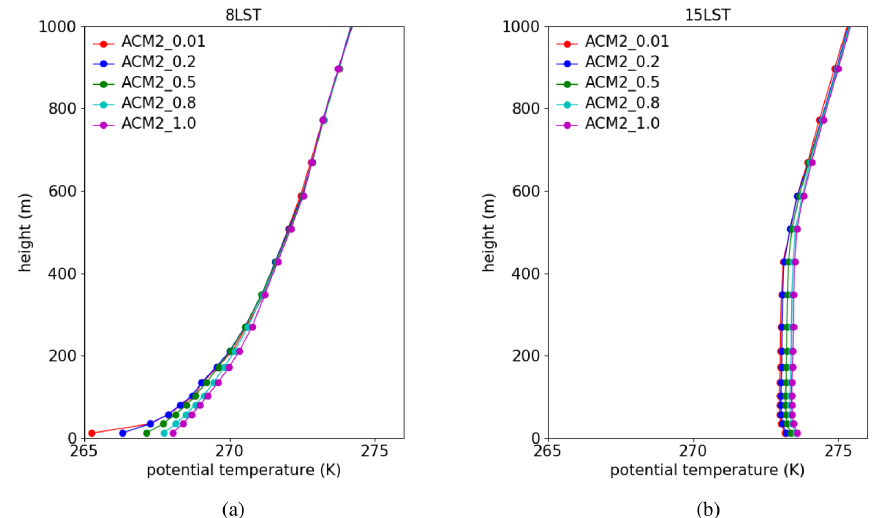
Figure 4. The vertical profiles of the potential temperature predicted by the ACM2 scheme with different K z min values at (a) 08:00LST and (b) 15:00LST averaged over the simulated